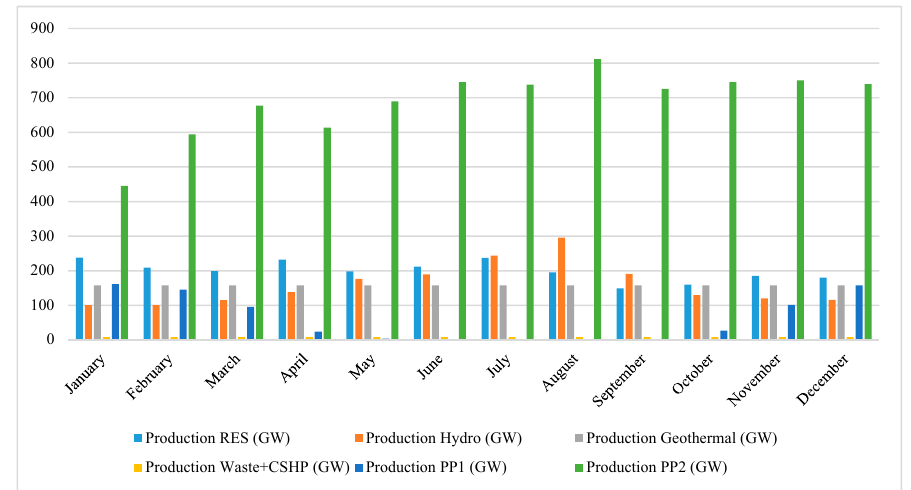
Figure 3. Electricity production by component wise for year 2030.